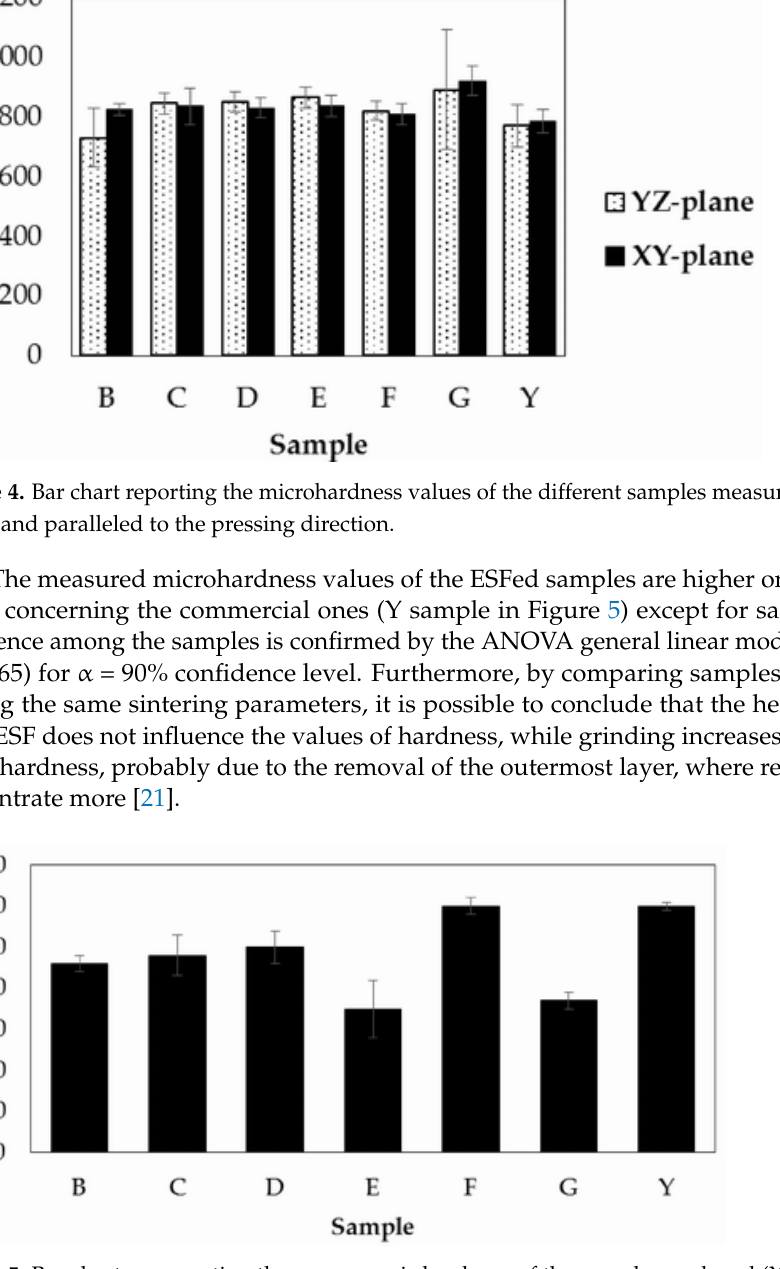
Figure 5. Bar chart representing the macroscopic hardness of the samples analyzed (XY